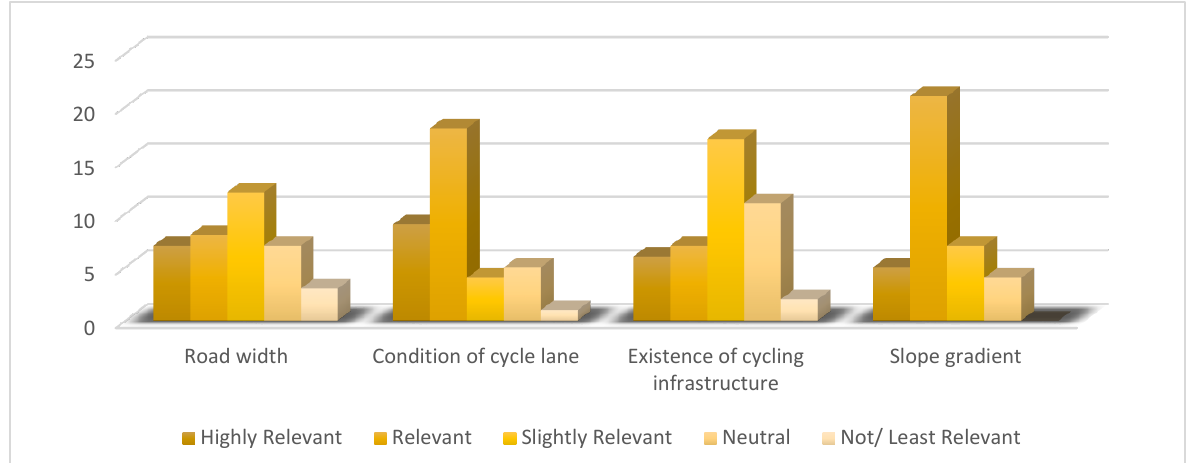
Figure 3: Impact of physical attributes and infrastructure on cycling in Johannesburg Cyclist safety is of great concern to city authorities (Dewar & Todeschini, 2004; City of Johannesburg, 2009; Selala